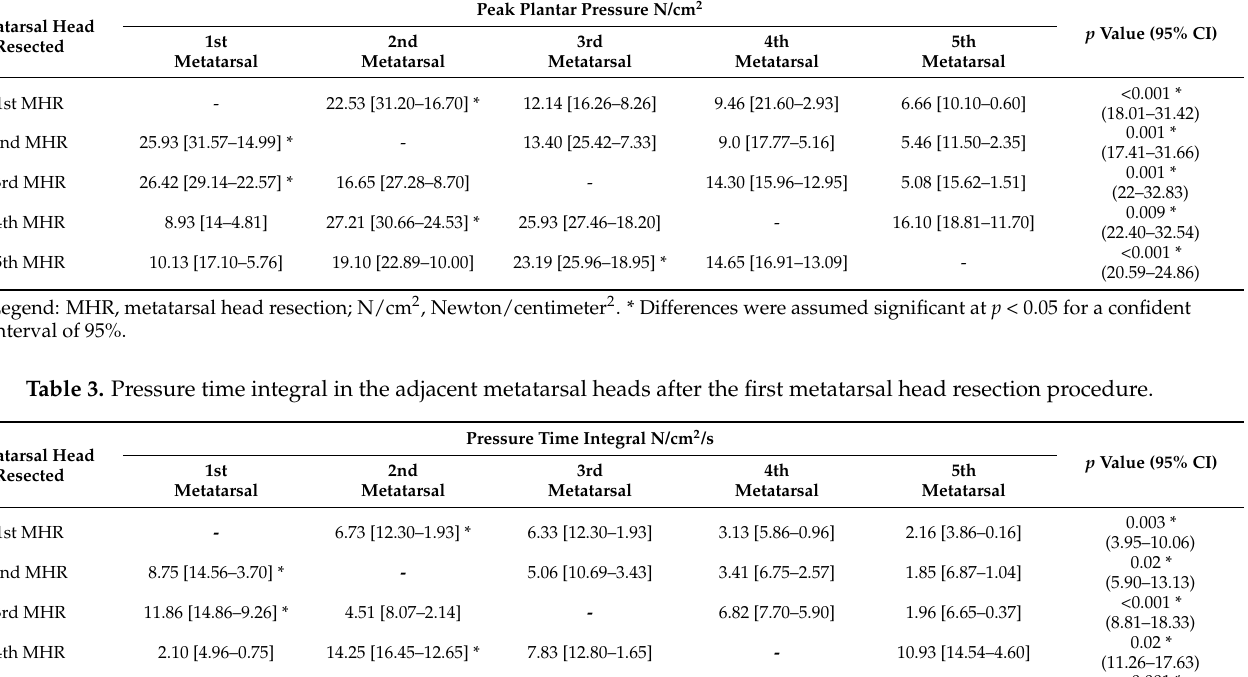
Table 2. Peak plantar pressure in the adjacent metatarsal heads after the first metatarsal head resection procedure. Metatarsal Head Resected